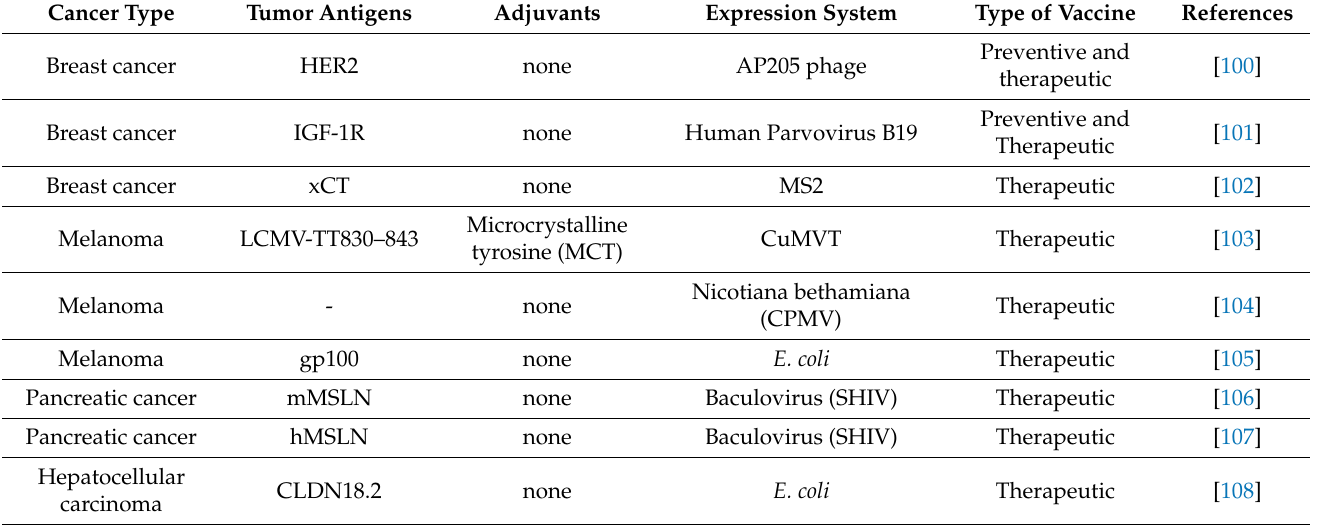
Table 3. VLPs for therapeutic